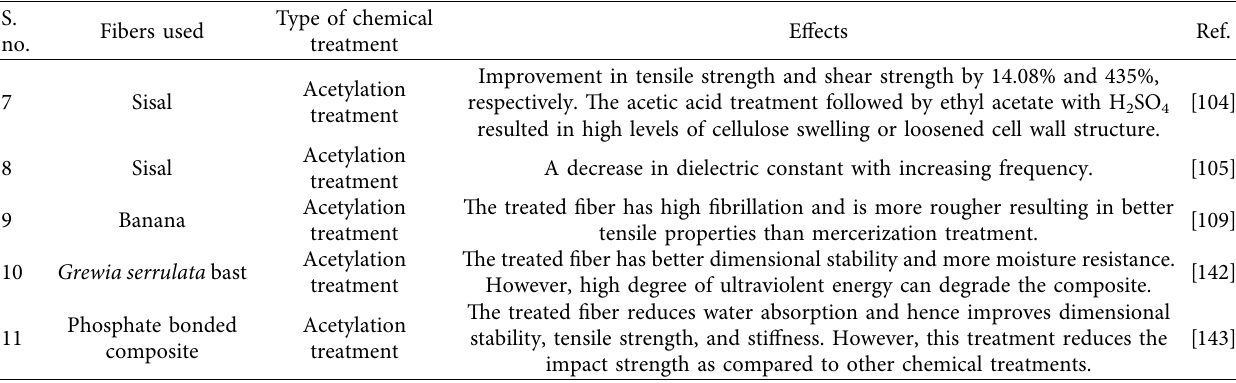
Table 4: Effect of permanganate (KMnO